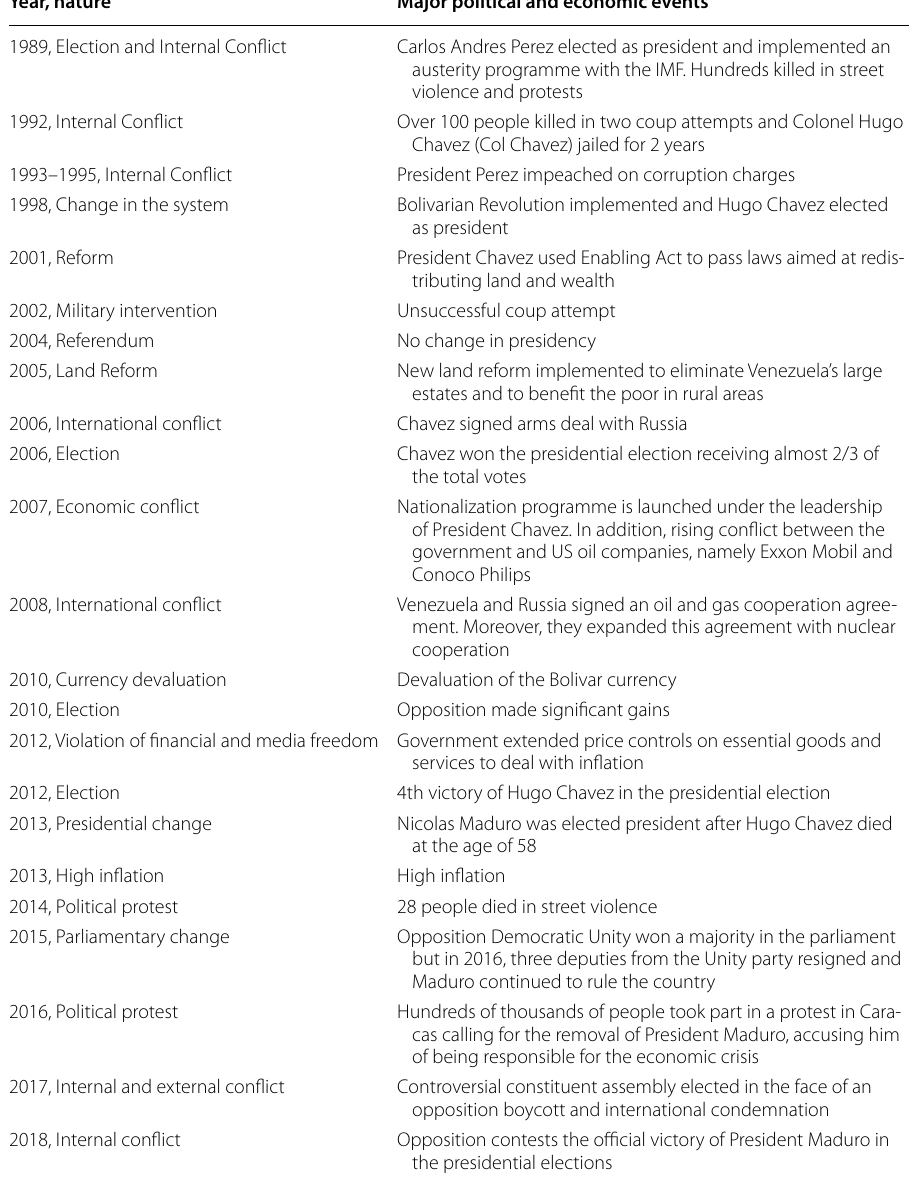
Table 1 Major political and economic events in Venezuela (1985–2018) (source: